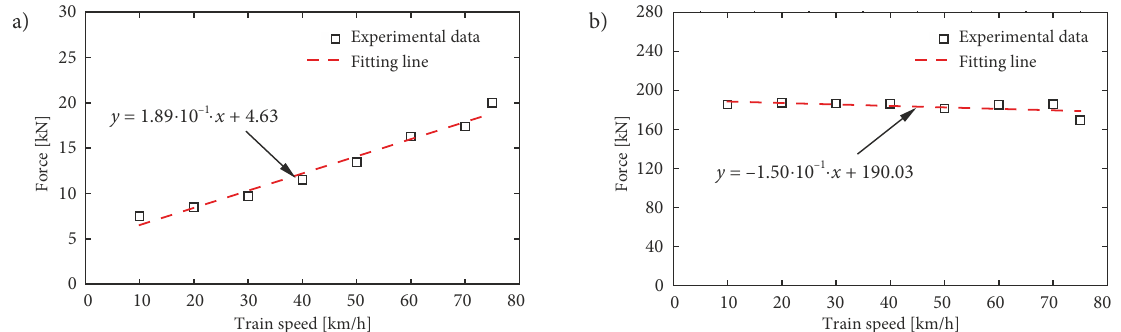
Figure 10. Variations of the peak values of the wheel–rail force with train running speed: a – lateral; b –